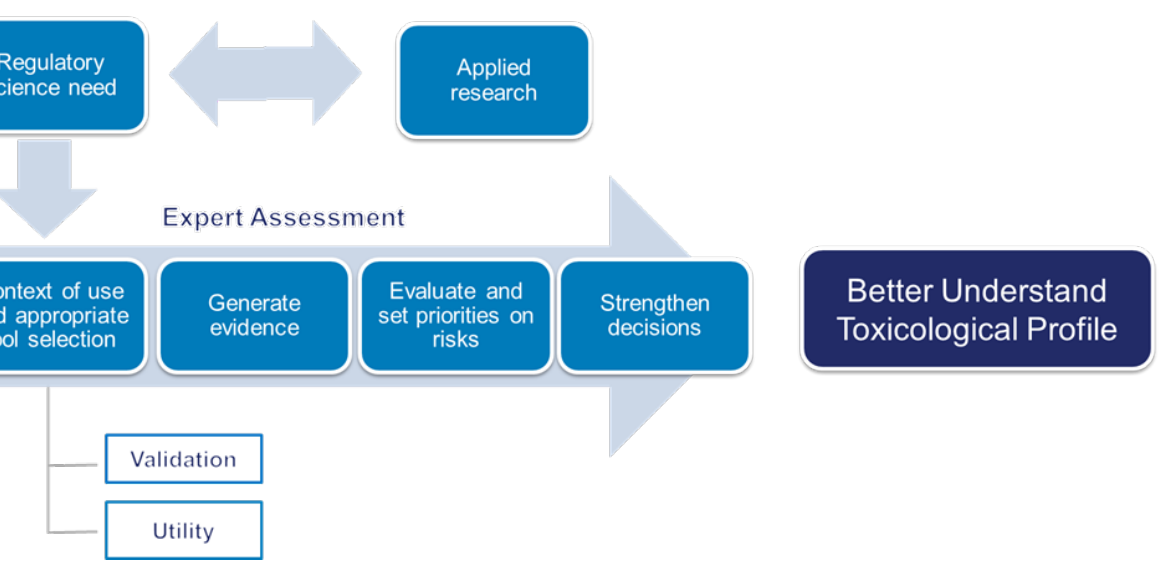
Figure 8. The role of computational toxicology in tobacco regulatory science (Part of NAM-05 presentation, Supplemental File).